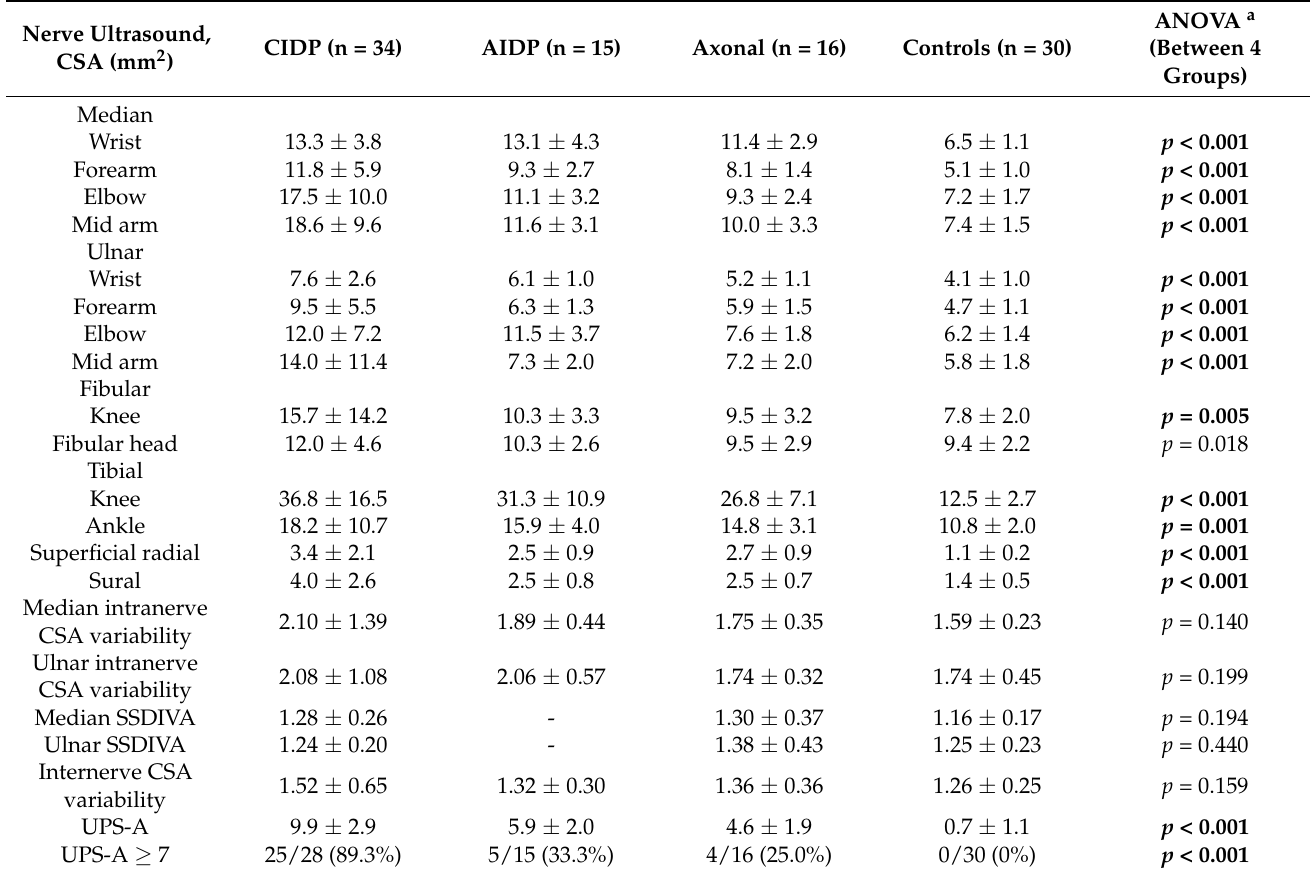
Table 2. Nerve ultrasound of CIDP and comparison with AIDP, axonal neuropathies and controls.